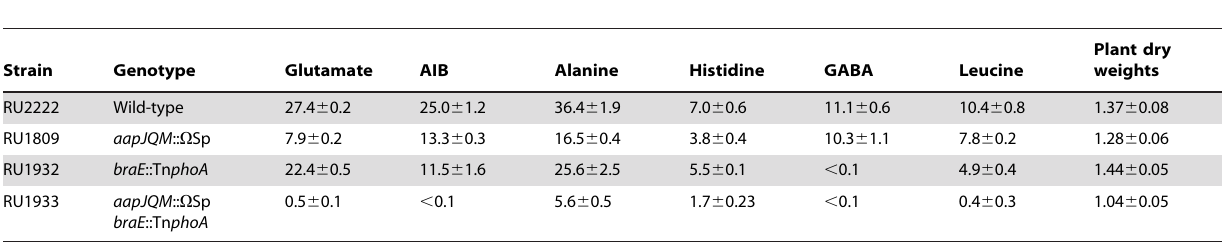
Strain Genotype Alanine Leucine Isoleucine Valine Plant dry